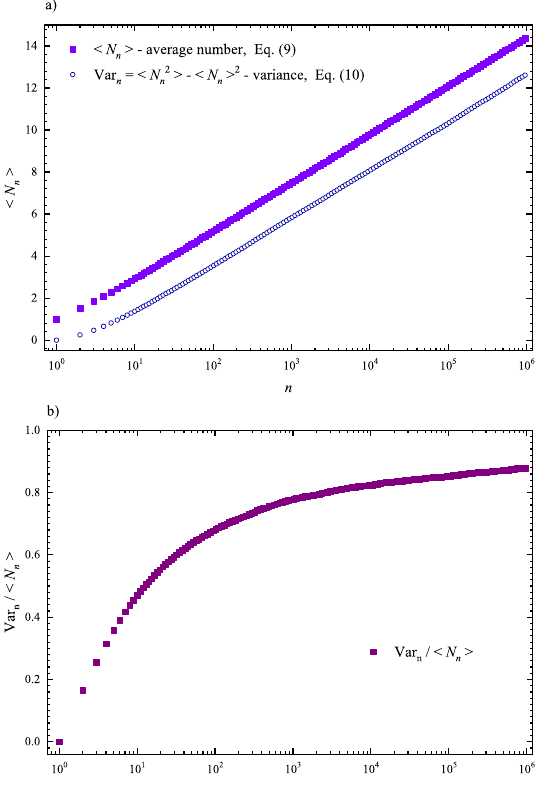
Figure 1. ( a ) The average number, (cid:104) N n (cid:105) , of record-breaking events versus time step n by Equation (9). ( b ) The index of dispersion of the record numbers is defined as the ratio of the variance to the mean value of the record numbers N n . This is given as the ratio of Equation (10) to Equation